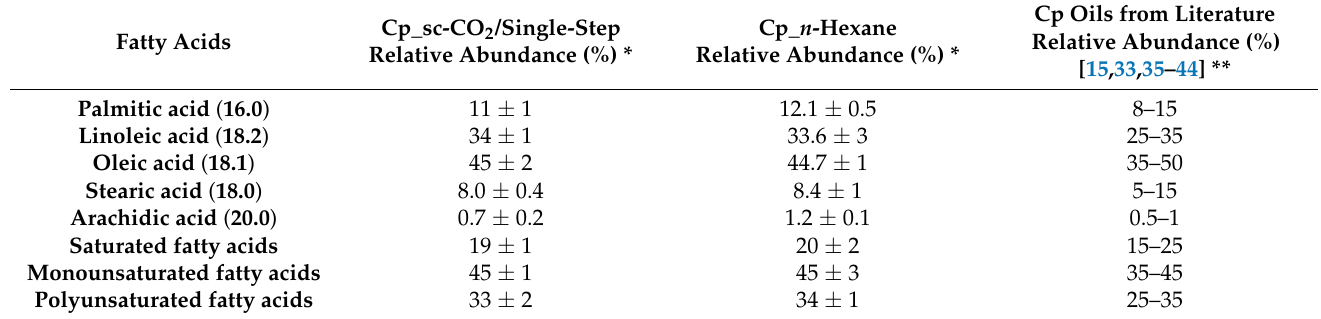
Table 2. Fatty acid relative abundances of CP extracts